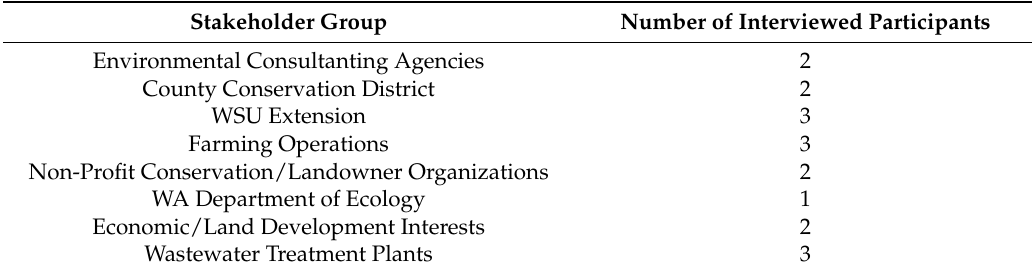
Table 1. Number of individuals interviewed in each stakeholder group *. These numbers do not include participants in the focus group or short group discussion unless they were also